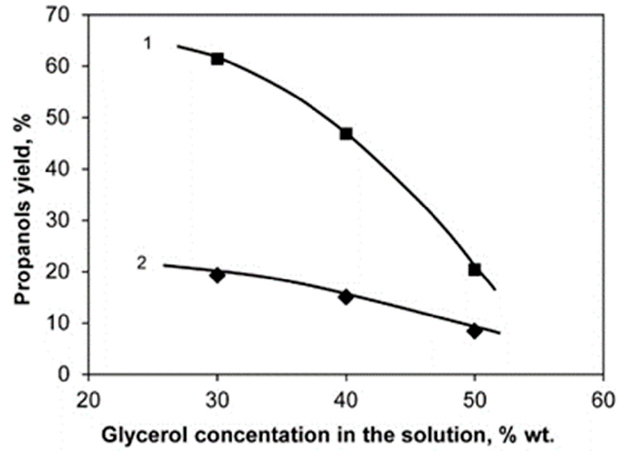
Figure 5. The dependence of the yield of 1-Pr (1) and 2-Pr (2) on the glycerol concentration in an aqueous solution at 100% glycerol conversion. Conditions: 20%Ni/18%WO 3 -ZrO 2 , Vcat. = 2 mL, T = 260 °C, LHSV = 1.66 h − 1 , P H2 = 2 MPa.